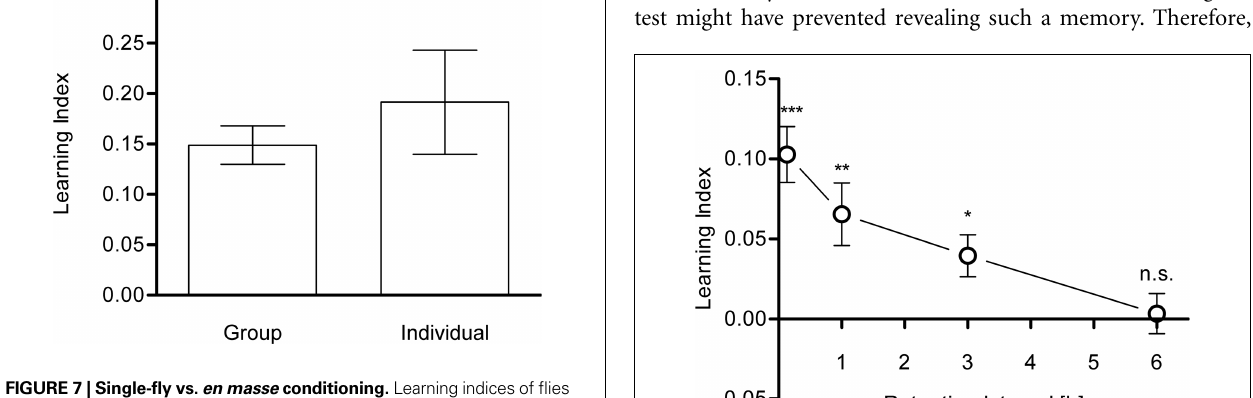
FIGURE 7 | Single-fl y vs. en masse conditioning. Learning indices of fl ies that undergo training and test in a group (Group) or individually (Individual) did not differ signifi cantly from each other [Welch’s t -test, t = 0.7742, P > 0.05] (27) despite signifi cantly different variances [ F -test, F = 0.859, P < 0.001). Both FIGURE 8 | Memory retention. Learning indices of fl ies that were trained (22,16) groups showed signifi cant memory [one-sample t -test, Group: t = 7.802, with four training trials and tested after 5 min., 1, 3 and 6 h. Signifi cant (16) P < 0.001; Individual: t = 3.716, P < 0.01]. Note that the learning index of memory was found up to 3 h after training [one-sample t -test, 5 min: (22) single-fl y conditioning is based on the time spent on CS + and CS − , whereas t = 5.891, P < 0.001; 1 h: t = 3.358, P < 0.01; 3 h: t = 3.008, P < 0.05]. (34) (34) (29) memory of en masse conditioning is measured with the differential After 6 h, no signifi cant memory was detected anymore [one-sample t -test, distribution of fl ies. n = 17 and 23. t = 0.2622, P > 0.05]. n = (15)